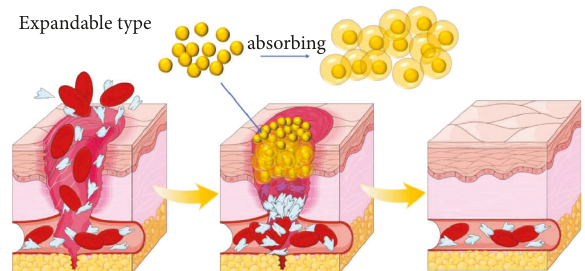
Figure 4: Through the material’s unique shape-memory large pore structure, it highly fits the size of the wound and quickly absorbs blood and water, effectively blocking the bleeding location and promoting